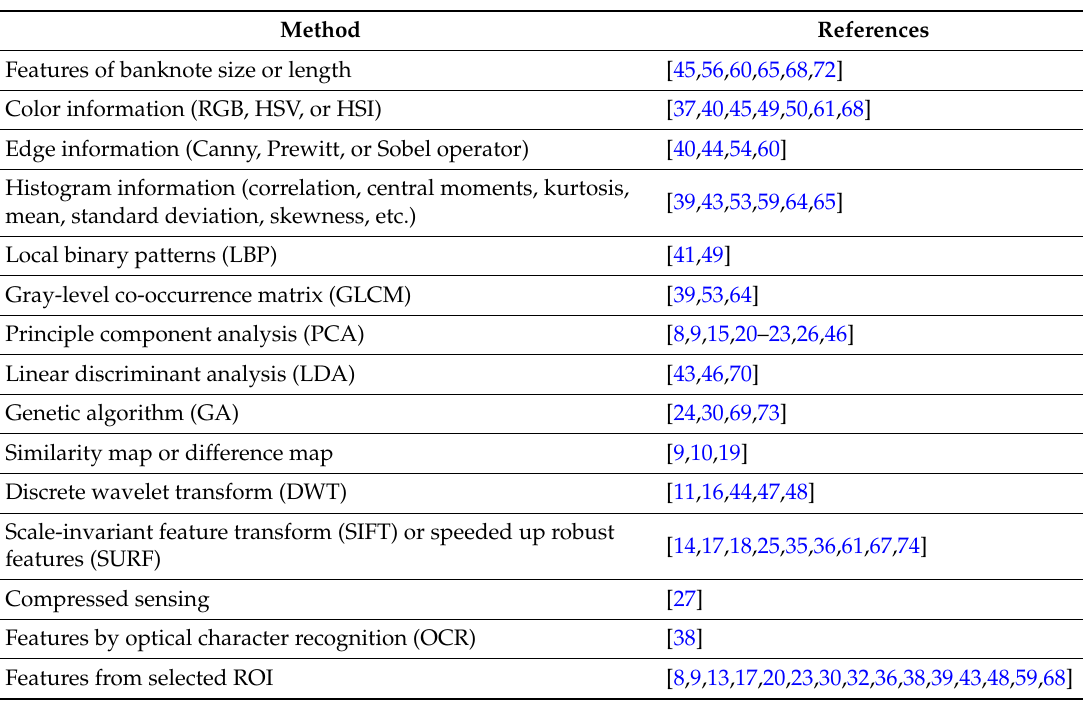
Table 3. Methods for feature extraction in the banknote recognition process